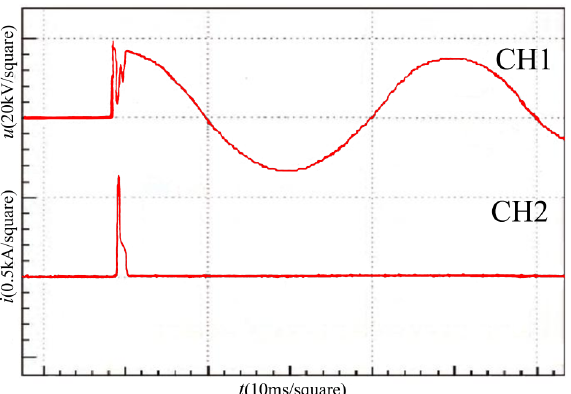
Figure 12. Combined test of high impulse current and power frequency freewheeling test voltage waveform (CH1) and current waveform